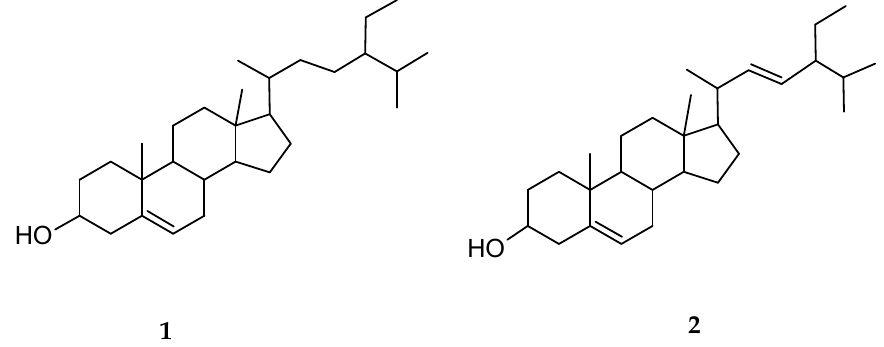
Figure 3. Chemical structures of β -sitosterol ( 1 ) and stigmasterol ( 2 ).